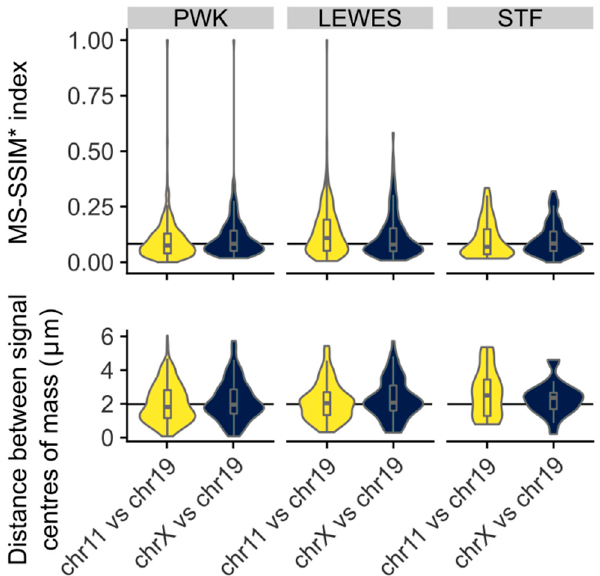
Figure 6. Chromosomes 11 and 19 do not colocalize within individual nuclei; colocalization of signals shows no difference comparing chr11 and chr19 as when comparing chrX and chr19 by either multi-scale structural similarity index (MS-SSIM*) (upper) or the distances between the chromosome signal centers (lower).